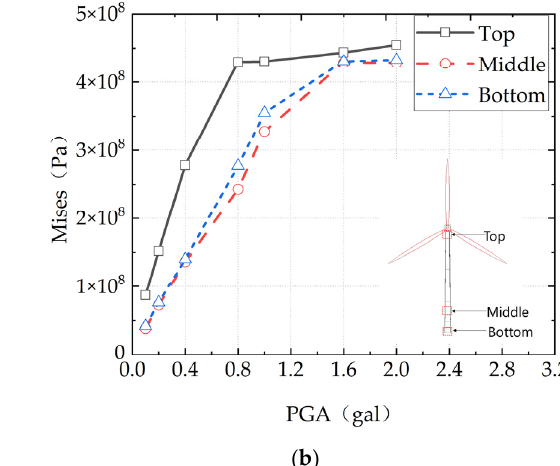
Figure 15. The Hyogoken-Nanbu earthquake: ( a ) structural APRC value; ( b ) maximum Mises stress.